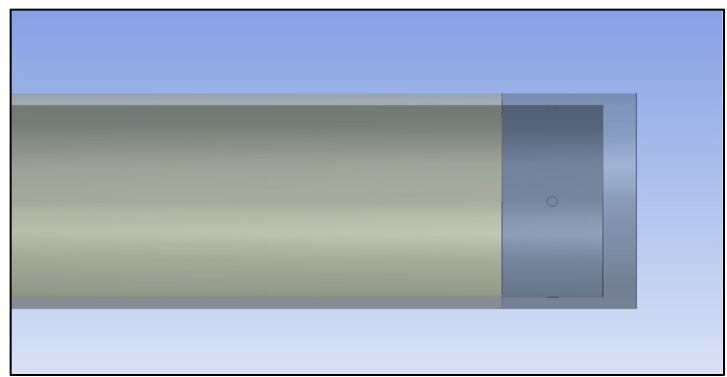
Figure 15. Schematic diagram of geometric